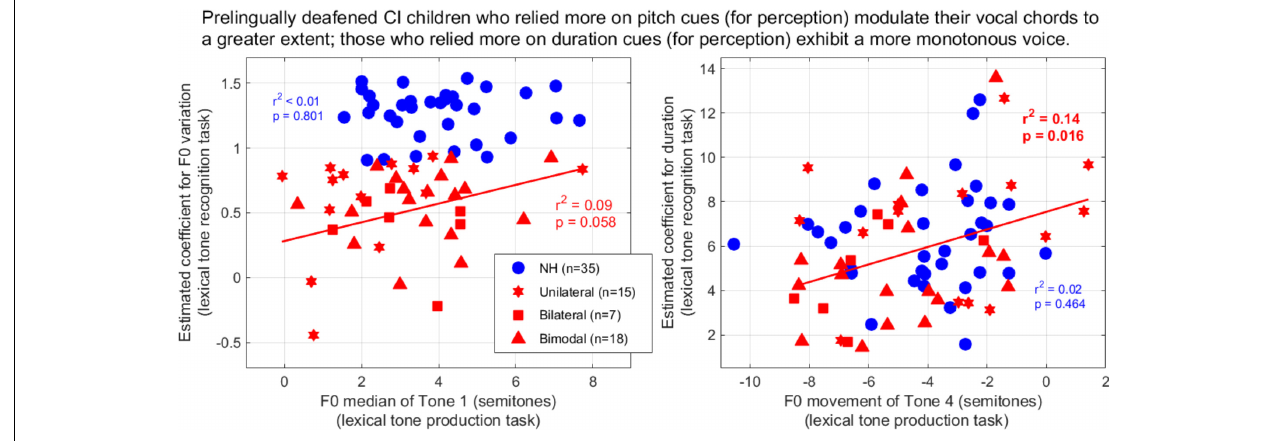
FIGURE 10 | Coefficients extracted from the logistic mixed-effect model reflecting the reliance on F0-variation (left) and duration (right) in the lexical tone recognition task, as a function of the F0 parameters extracted from production. Coefficients for F0 variation are expressed in log 10 of their absolute value to improve homogeneity of variance between the two participant